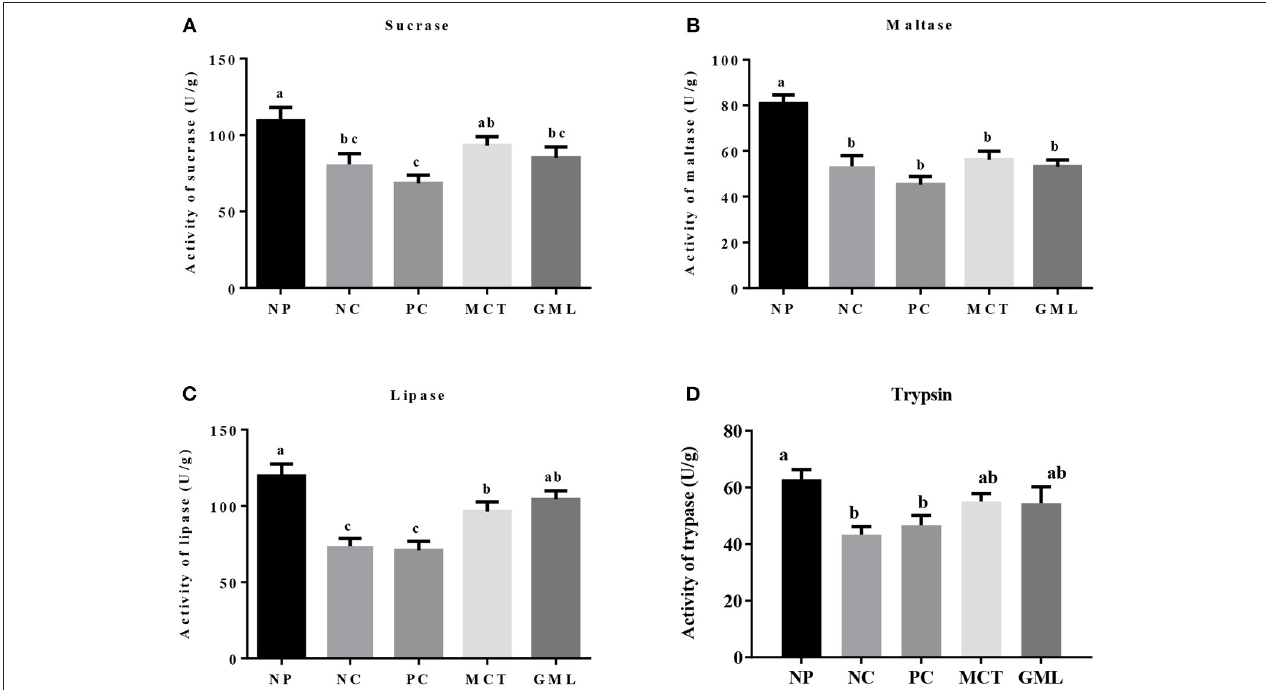
FIGURE 2 | (A–D) The jejunal digestive enzyme activity. a − c Mean values sharing different superscripts within a row differ ( P < 0.05). Values are the mean ± SEM, n = 6. NP, normal protein basal diet no antibiotics included; NC, low-protein basal diet no antibiotics included; PC, low-protein basal diet + antibiotics (75 mg/kg quinocetone, 20 mg/kg virginiamycin and 50 mg/kg aureomycin); MCT, low-protein basal diet + 2 kg/T tricaprylin/tricaprin; GML, low-protein basal diet + 2 kg/T glycerol